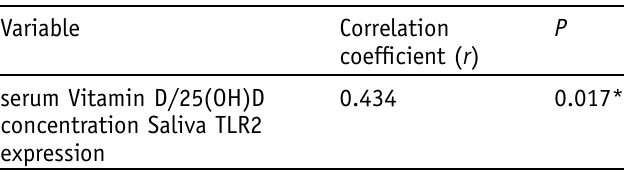
Table II. The result of The Spearman correlation test between serum vitamin D/25(OH)D concentration and TLR2 expression of neutrophils in saliva of